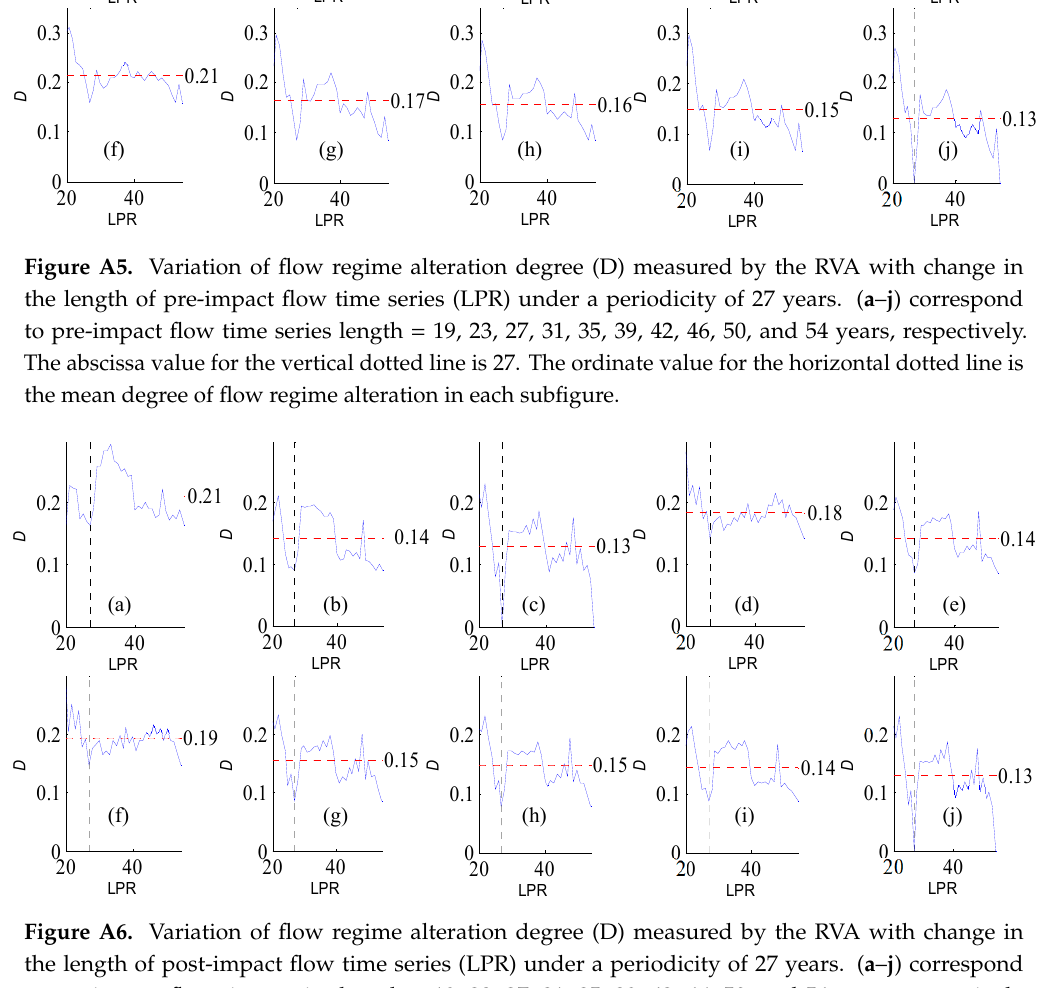
Figure A6. Variation of flow regime alteration degree (D) measured by the RVA with change in the length of post-impact flow time series (LPR) under a periodicity of 27 years. ( a ), ( b ), ( c ), ( d ), ( e ), ( f ), ( g ), ( h ), ( i ), and ( j ) correspond to pre-impact flow time series length = 19, 23, 27, 31, 35, 39, 42, 46, 50, and 54 years, respectively. The abscissa value for the vertical dotted line is 27. The ordinate value for the horizontal dotted line is the mean degree of flow regime alteration in each subfigure.